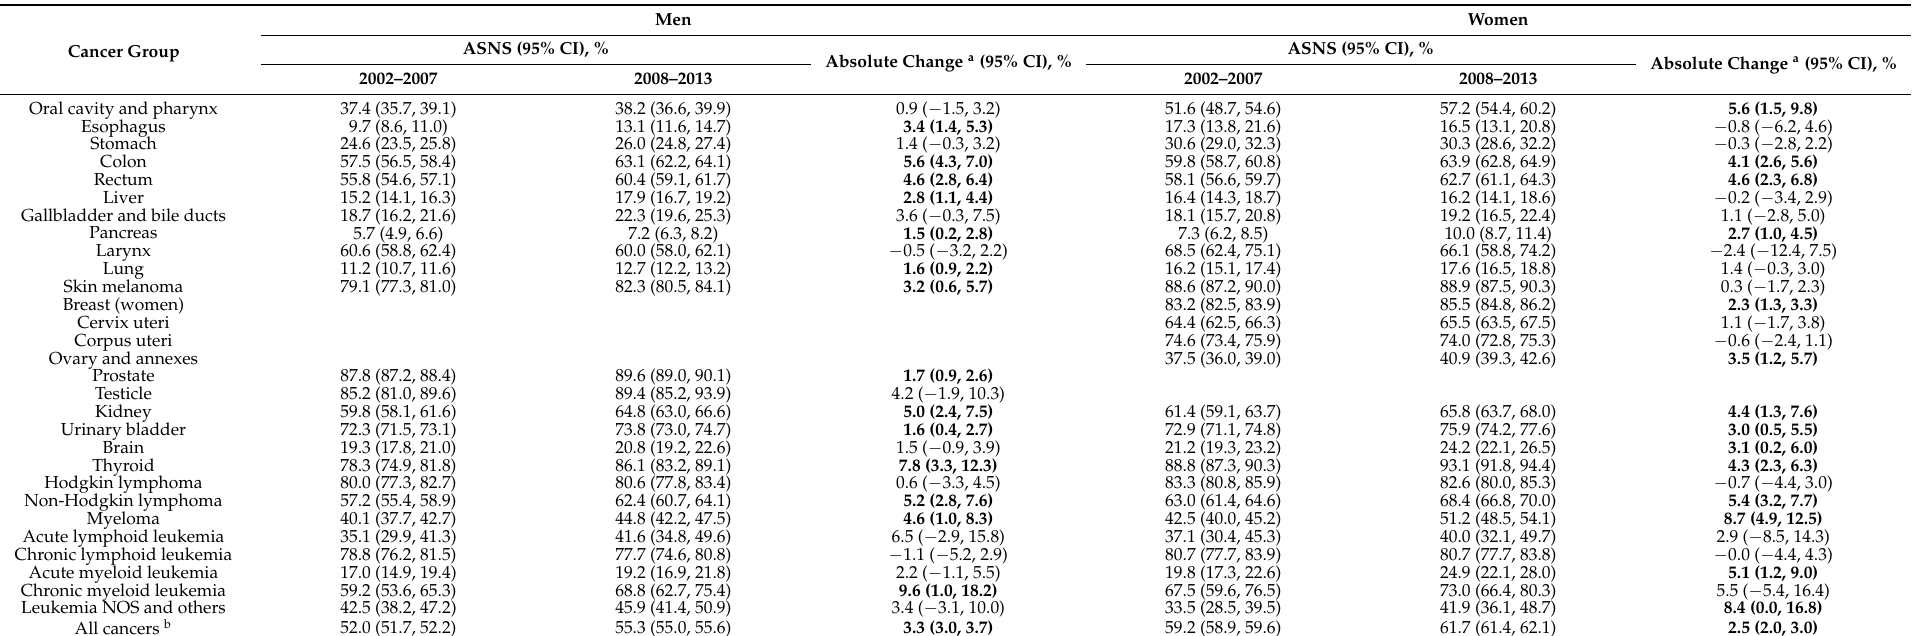
Table 4. Five-year age-standardised net survival (ASNS) in men and women diagnosed with cancer in Spain in 2002–2007 and 2008–2013 and absolute change between